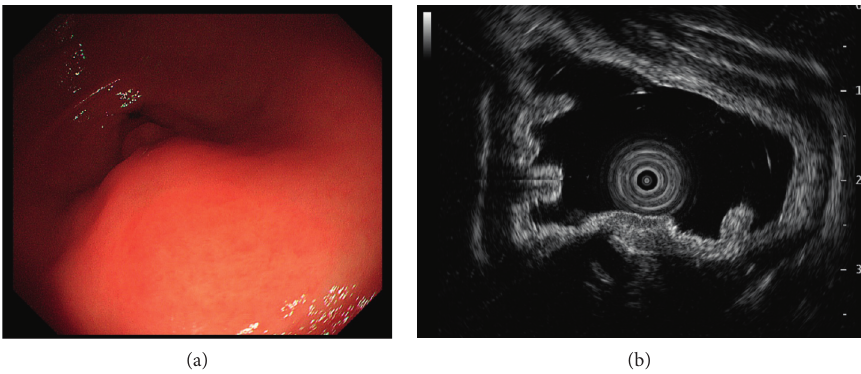
Figure 1: (a) Esophagogastroduodenoscopy (EGD) image. EGF revealed a pedunculated mass resembling a submucosal tumor in the antrum of the stomach. (b) Endoscopic ultrasonography image. The lesion was located in the submucosa and muscularis propria, and the mass was poorly defined and hypoechogenic.